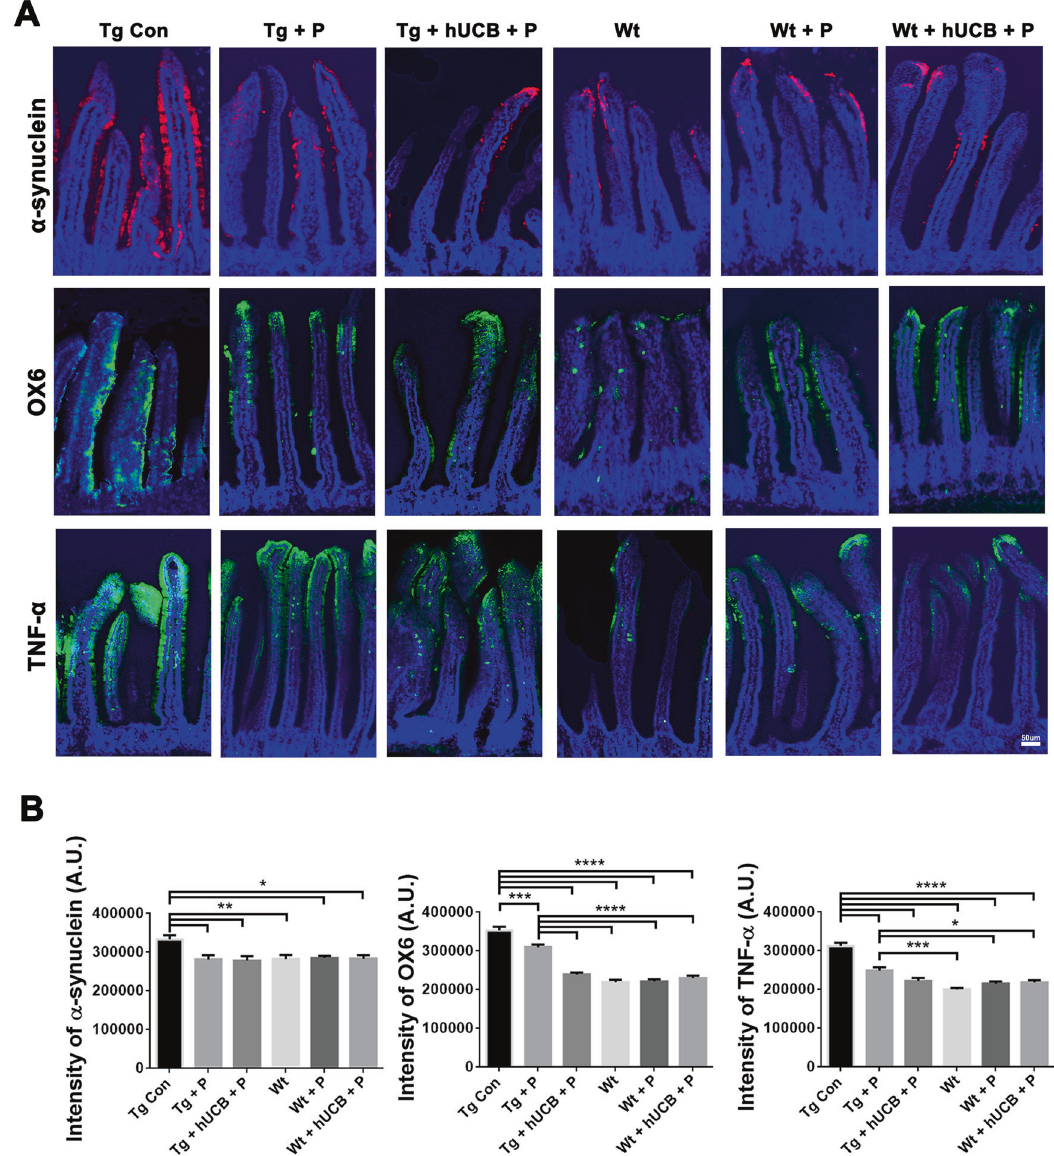
Fig. 4 Intestinal villi in fl ammation, and α -synuclein load. A Immunohistochemical staining of the intestinal villi was conducted to elucidate alterations in cell population expression for α -synuclein (red), OX6 (green), and TNF- α (green) with DAPI (blue). Immuno fl uorescent microscopy was used to collect the images, of which representative samples are displayed according to animal group and factor of interest (Scale bar = 50 um). B ANOVA revealed signi fi cantly elevated α -synuclein intensity level (* p < 0.01) signi fi cantly elevated OX6 expression (**** p < 0.0001), and signi fi cantly elevated TNF- α expression (**** p < 0.0001) in Tg vs Wt animals. Additionally, post hoc Bonferroni ’ s test analysis revealed P and hUCB + P treatment signi fi cantly reduced (* p < 0.05) the in fl ammatory response in Tg animals (* p < 0.05, ** p < 0.01, *** p < 0.001, **** p <